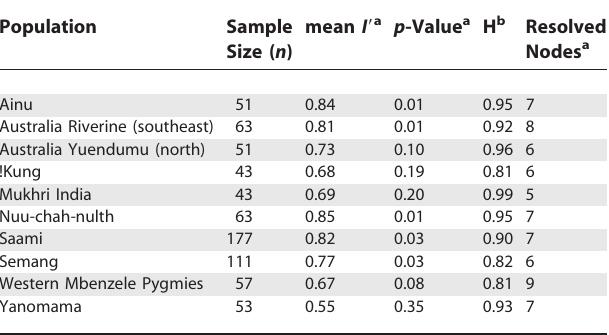
Table 8. mtDNA Genealogy Imbalance for HGPs